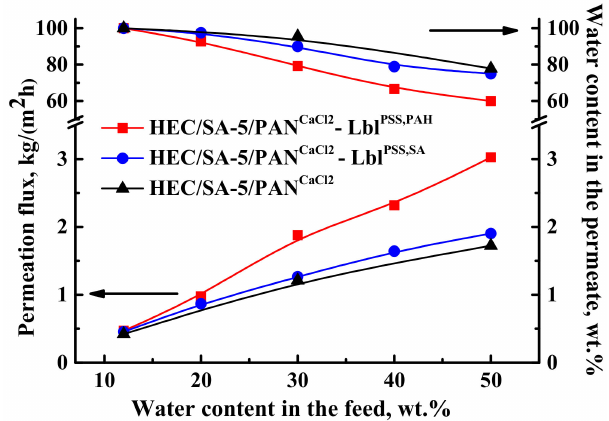
Figure 14. The dependence of permeation flux and water content in the permeate on the water content in the feed for the supported HEC/SA-5/PAN CaCl2 , HEC/SA-5/PAN CaCl2 —Lbl PSS,PAH , and HEC/SA-5/PAN CaCl2 —Lbl PSS,SA membranes in pervaporation dehydration of isopropanol (12–50 wt.% water) at 22 ◦